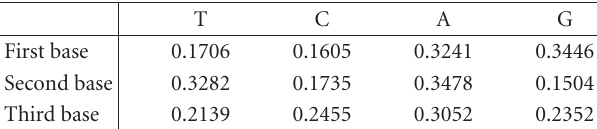
Table 5: Fractions of nucleotides at the three base sites of a codon in the coding sequence of Aquifex aeolicus